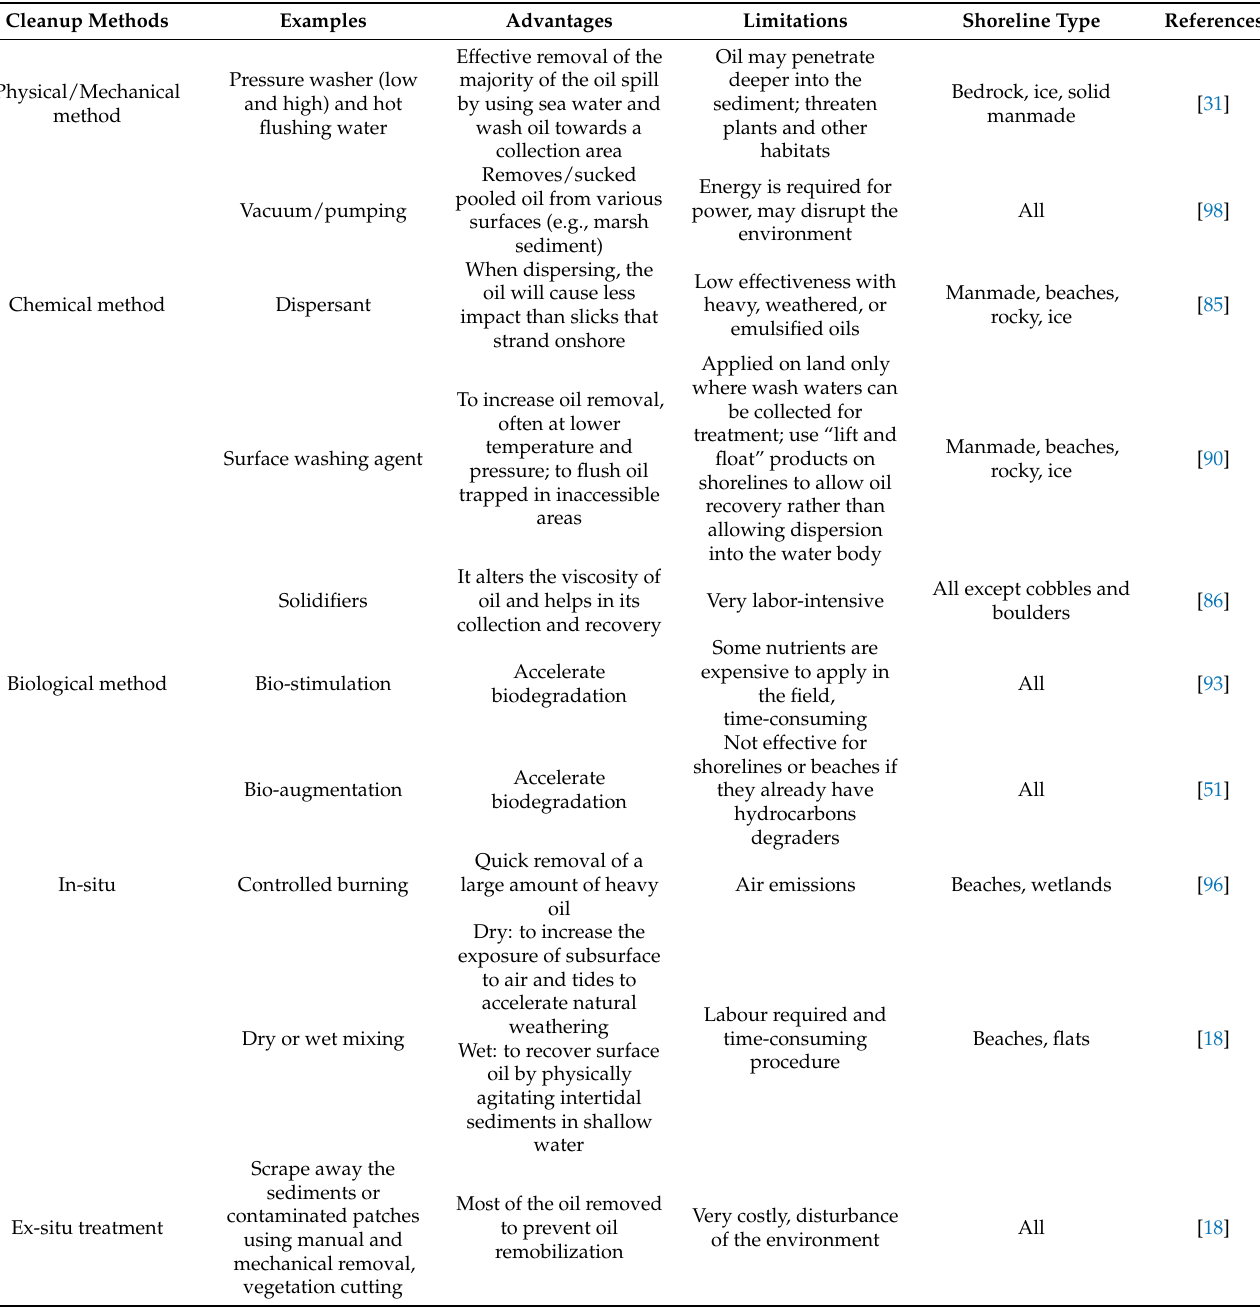
Table 3. Pros and Cons of oil cleanup techniques for